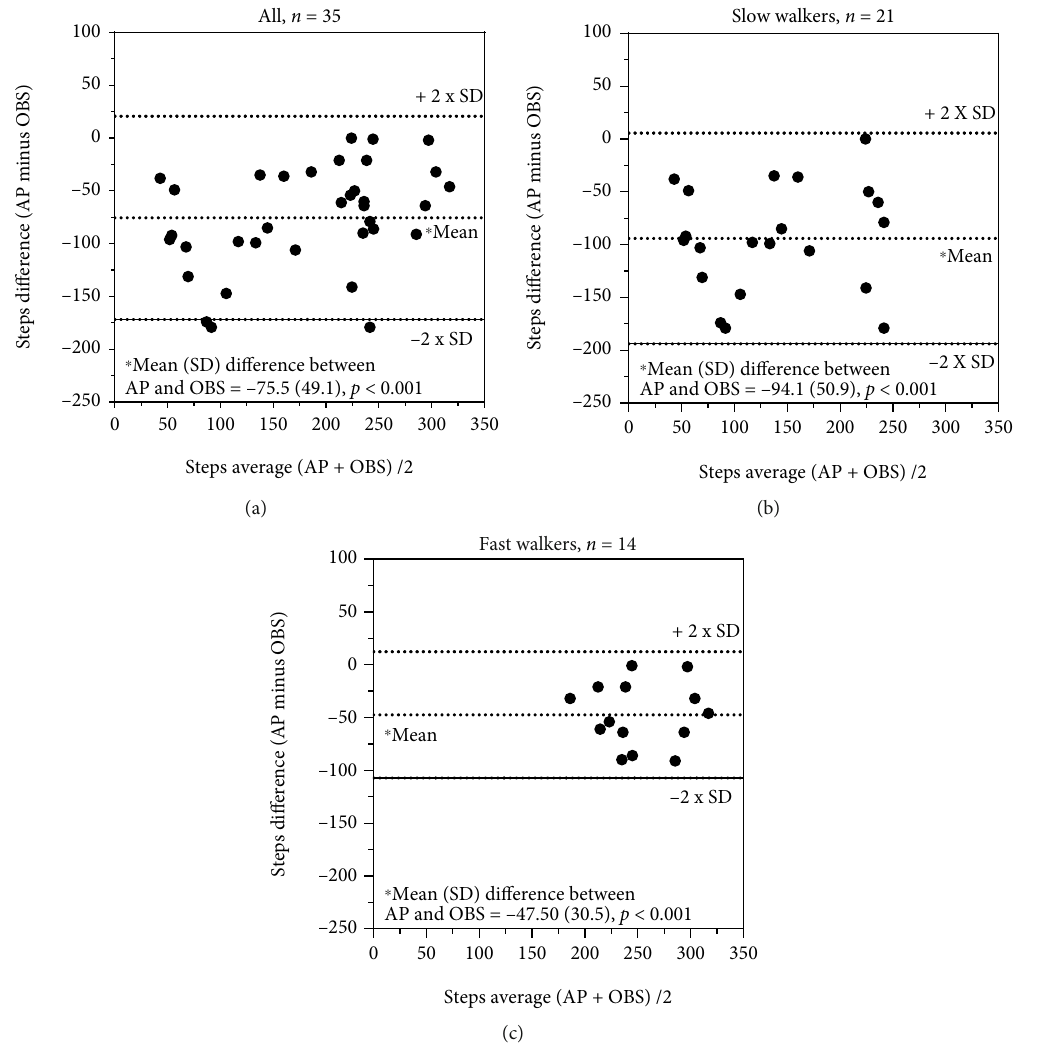
Figure 1: (a – c) Recording of steps: comparison between ActivPAL3 ™ and direct